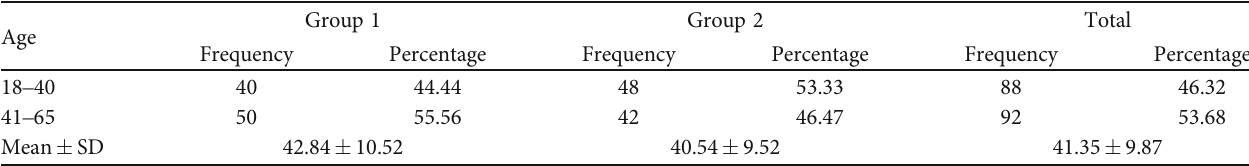
ABLE 1: Distribution of patients according to age in both groups.